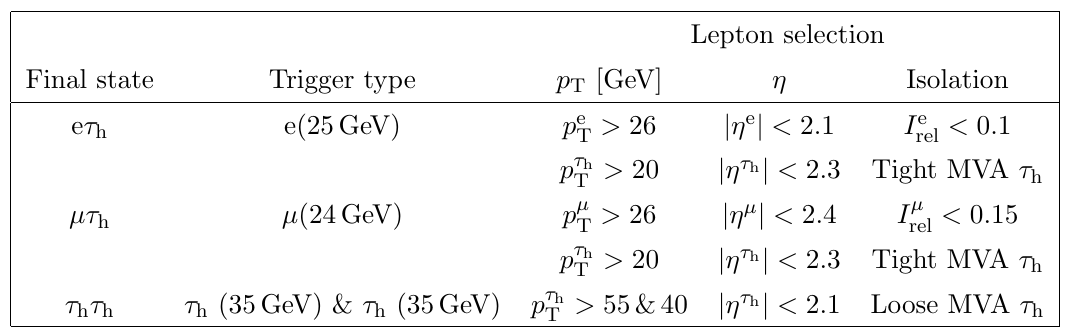
Table 2 . Selection requirements for the three (cid:28)(cid:28) decay channels. The p T thresholds for the triggers are given in the second column in